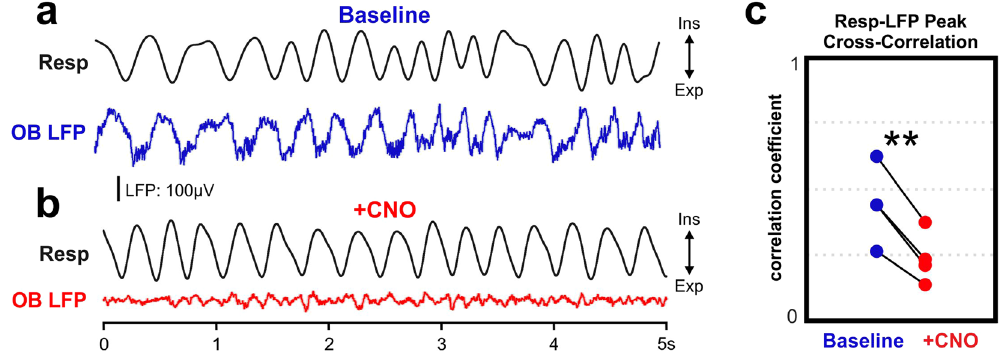
Figure 2. Disruption of olfactory bulb respiration-locked oscillations with administration of inhibitory DREADDs channel activator Clozapine-N-oxide (CNO). ( a ) Baseline example of simultaneously recorded olfactory bulb LFP and respiration shows robust neuronal oscillations in OB locked to the respiratory cycle. Time and voltage scale apply to ( a , b ). Troughs in respiration trace correspond to the end of expiration. ( b ) Example of olfactory bulb LFP after systemic injection of CNO solution. Respiration-locked neuronal oscillations are visibly disrupted. ( c ) Group data showing disruption of respiration-locked OB activity following CNO injection. Peak correlation values were taken to account for variable latency of respiration-driven oscillations. 10 minutes of resting data were used to calculate each cross correlation. Paired T-test: ** p < 0.01. Exp: expiration; Ins: inspiration.